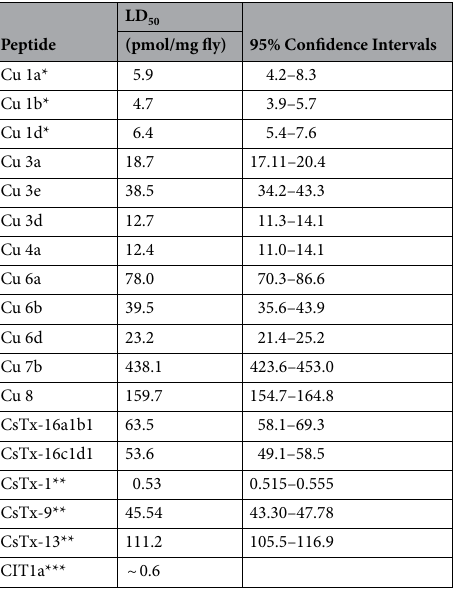
Table 3. Insecticidal activities of selected cupiennins, CsTx-16 variants, neurotoxins CsTx-1, CsTx-9, and CsTx-13, and cyto-insectotoxin CIT1a. Different concentrations of peptides were dissolved in 0.1 M ammonium acetate, pH 6.1, and 0.05 µl was injected into Drosophila flies. The lethal dose (LD 50, pmol/mg fly), where 50% of the flies die after 24 h, was calculated with PRISM Vers. 6.07. * Data are from 14 , ** from 25 , *** from 18 , using flesh